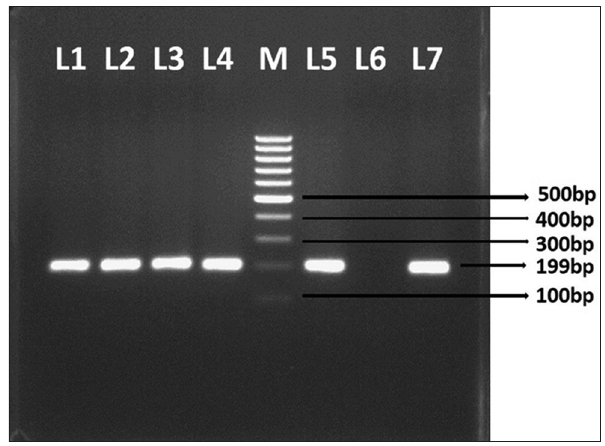
Figure-3: Polymerase chain reaction amplification of tdh gene of Vibrio parahaemolyticus, Lane 1, 2, 3, 4, 6: Sample DNA (C2, C25, C57, S8, S38) with positive amplicon (199 bp), Lane 5: DNA ladder of molecular weight 100 bp, Lane 7: Negative control, Lane 8: Positive control ( V. parahaemolyticus Vp-Kx-V Strain), C - Crab, 138 S –